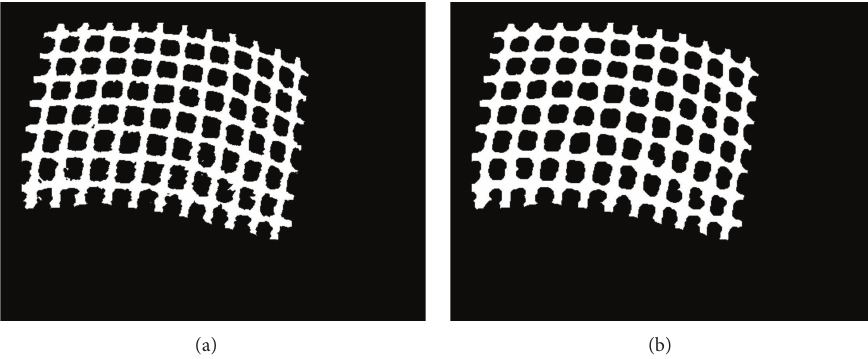
Figure 8: (a) Binary image before dilation and erosion (holes and spikes), (b) image after dilation and erosion process.